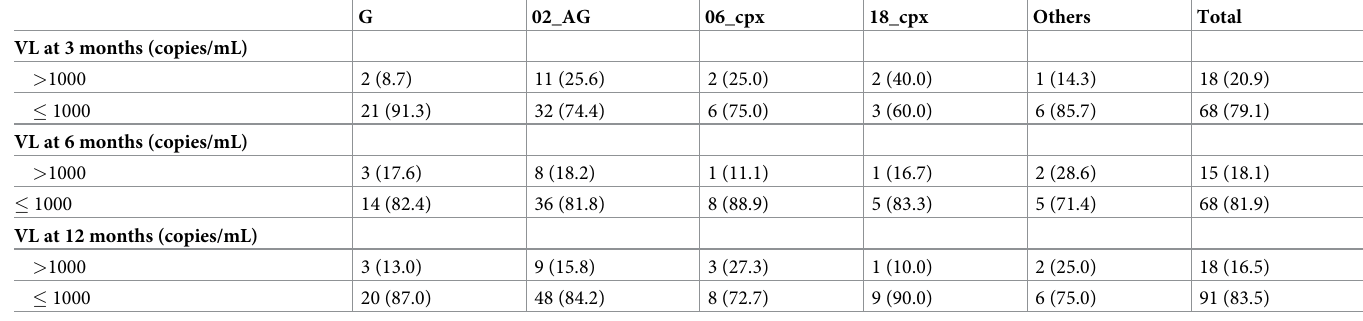
Table 3. Proportion with viral suppression (VL � 1000 copies/mL)at 3 months, 6 months and 12 months after initiation of ARV drugs.